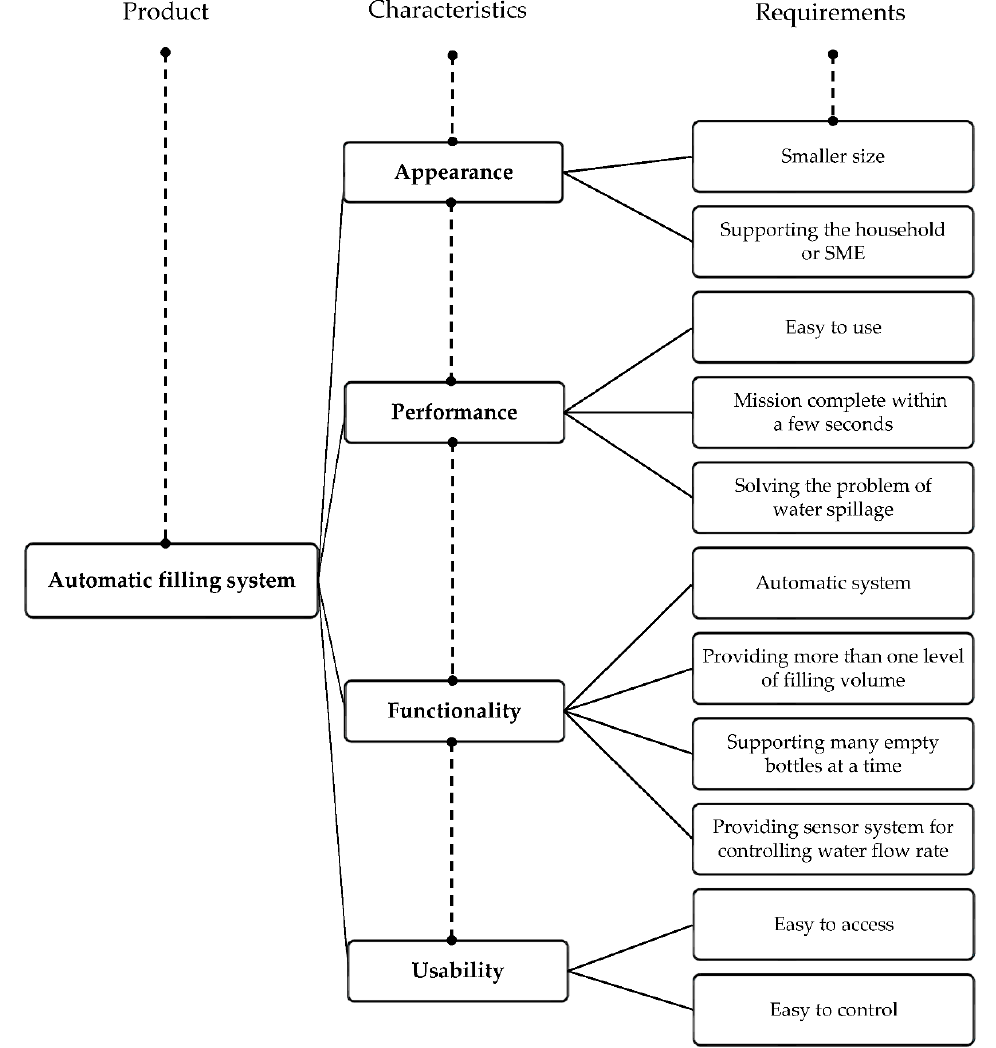
Figure 6. Specific requirements for creating the automatic filling machine.